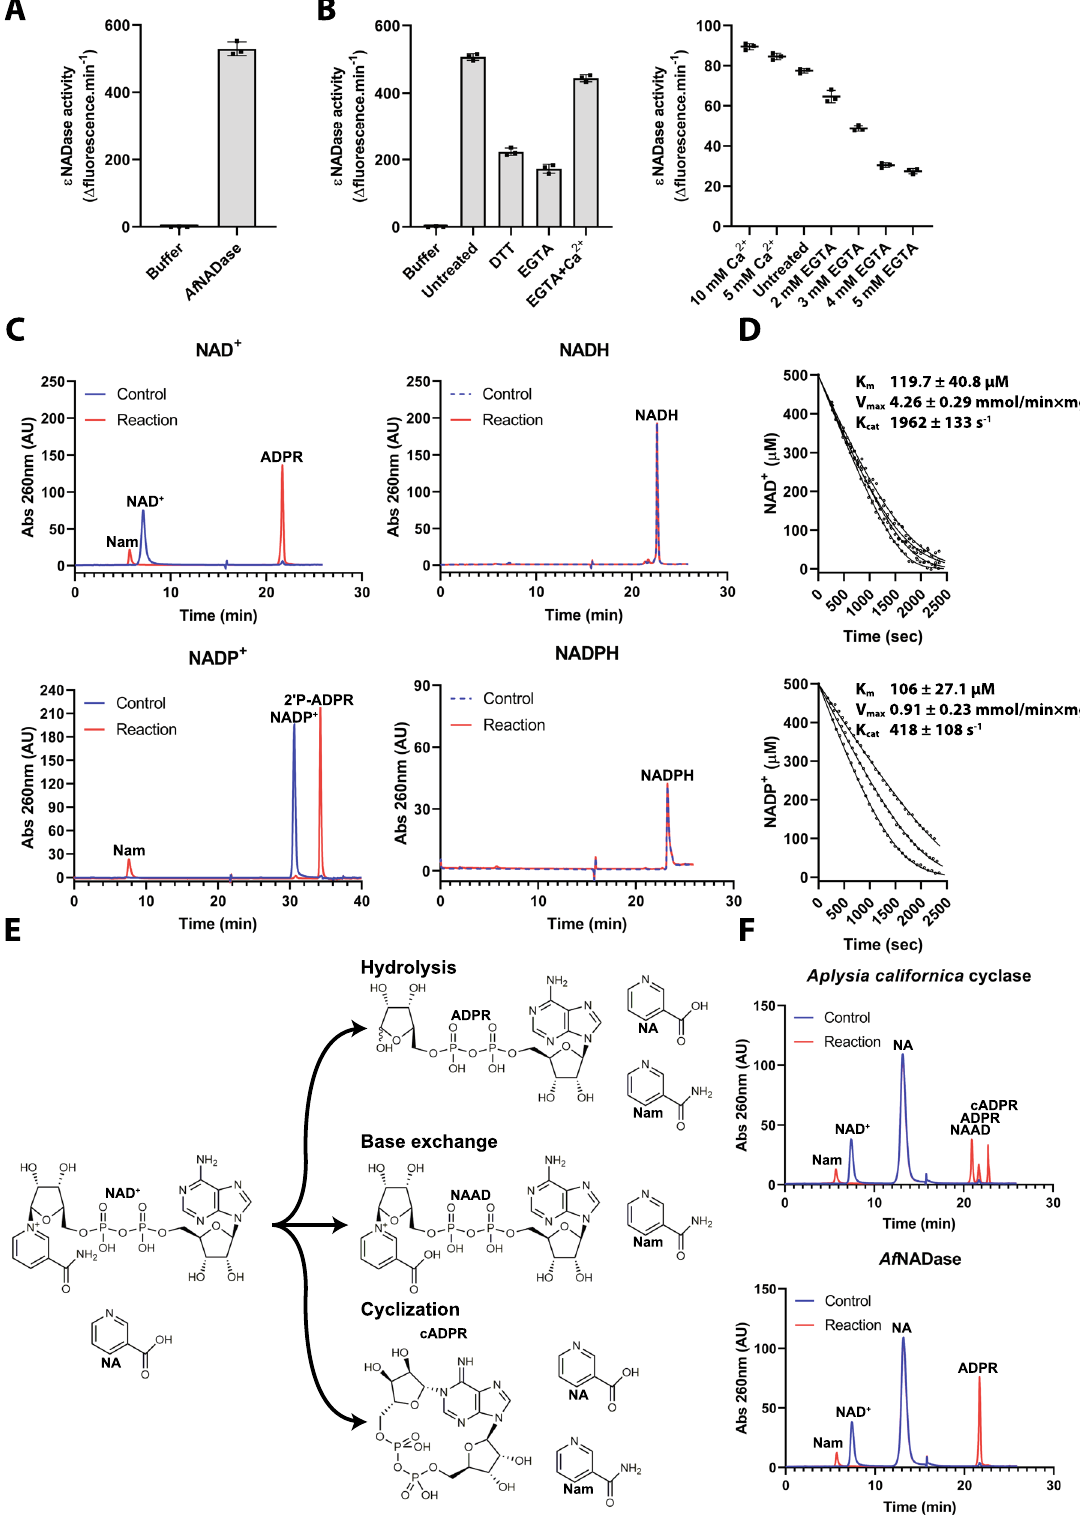
catalysis cannot be easily explained. Since the activity is lower in the Ca 2 + binding site mutant, it is tempting to speculate that the Ca 2 + ion plays a role in regulation of the enzymatic activity to prevent suicidal NAD(P) + depletion as the intracellular concen- tration of Ca 2 + is in the nanomolar range in conidia 17